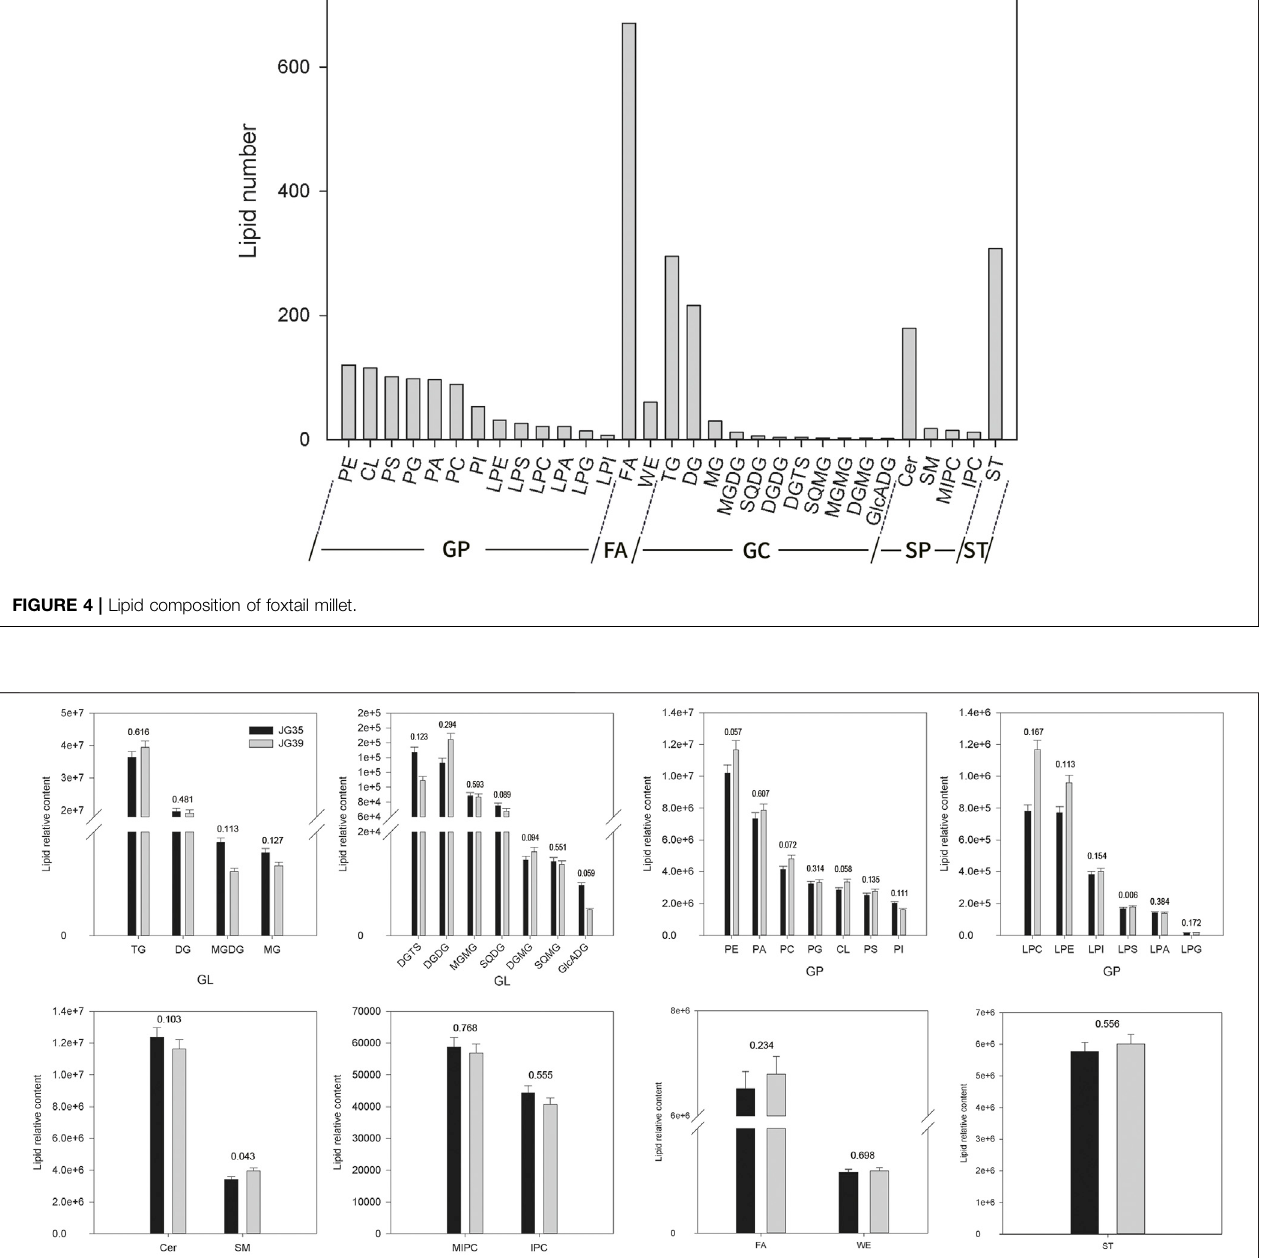
FIGURE 5 | Comparison of lipid subgroup contents between JG 35 and JG39 (The values in the fi gure represent p values).